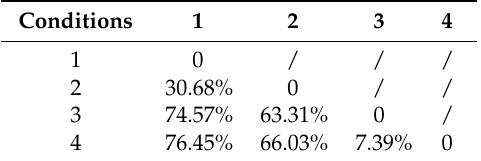
Table 5. The increased percentages under every